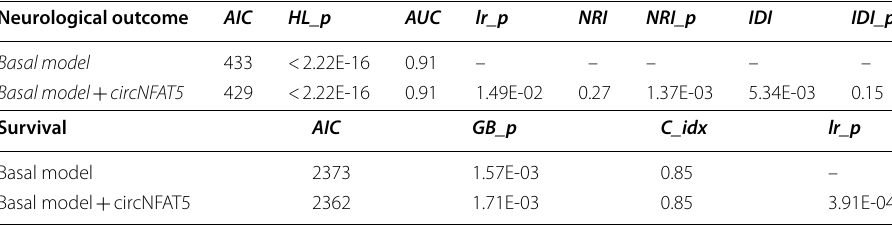
Basal model + Incremental value of circNFAT5 to predict neurological and survival in TTM-trial patients. The basal model included age, sex, first monitored rhythm, bystander cardiopulmonary resuscitation (CPR), circulatory shock on admission, targeted temperature regimen, time from CA to ROSC, initial serum lactate levels and NSE levels at 48 h. AIC Akaike Information Criterion, HL Hosmer–Lemeshow, AUC area under the curve, GB Gronnesby and Borgan, C_idx Harrell’s C-index, IDI integrated discrimination improvement, IDI_p integrated discrimination improvement p -value, lr_p likelihood ratio test p -value, NRI net reclassification improvement, NRI_p net reclassification improvement p -value